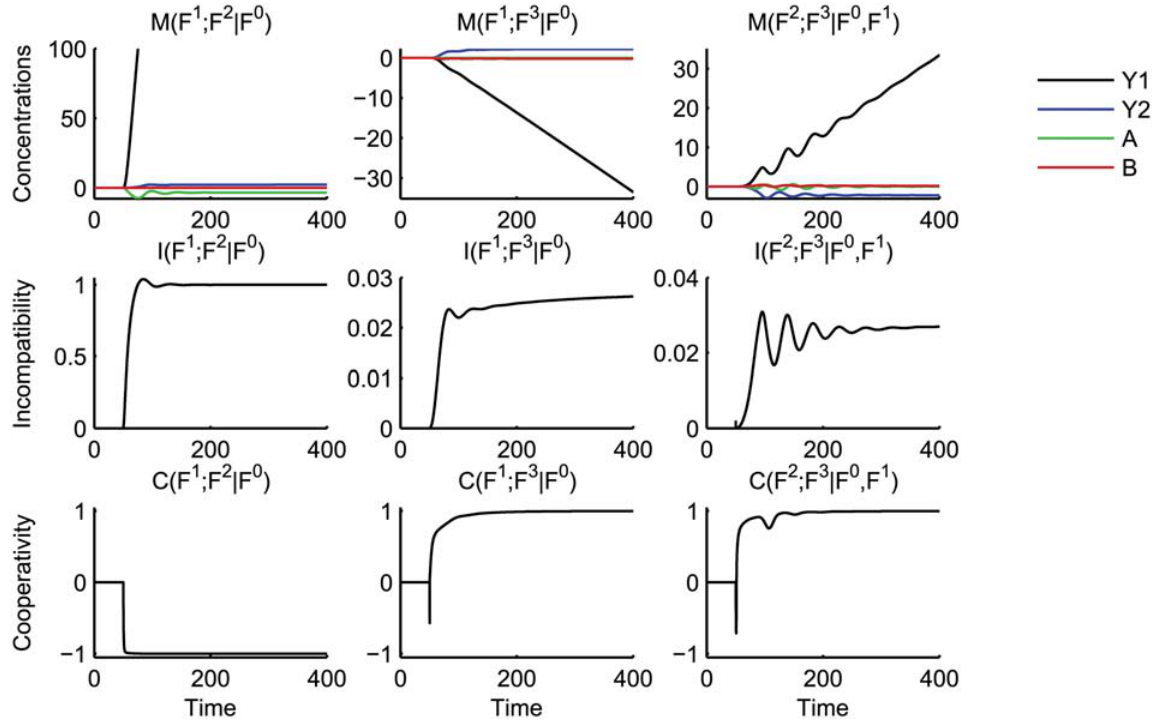
Fig 9. Mutual dynamics, incompatibilities and cooperativities between the functionalities of the perfect adaptation network. The first column shows the interaction of the pathway ( F 1 ) with the first controller ( F 2 ), the second column the interaction of the pathway with the second controller ( F 3 ), and the third column the interaction of the two controllers given the